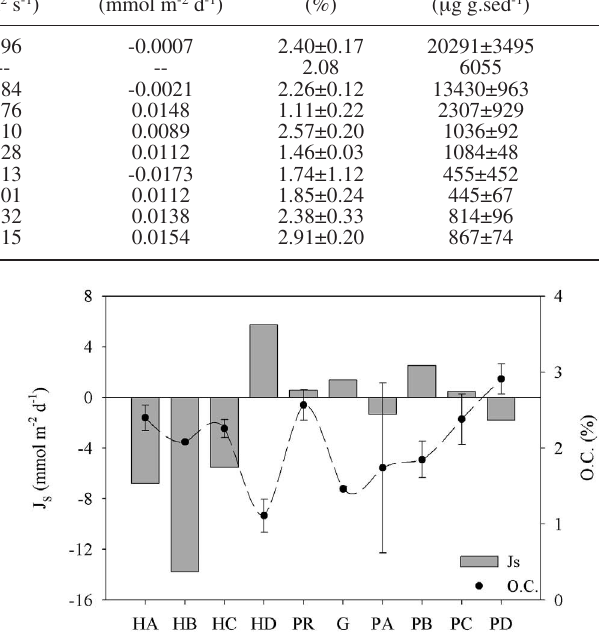
Fig . 4. – Benthic fluxes of phosphate (J tent (OC) in surface sediment at each